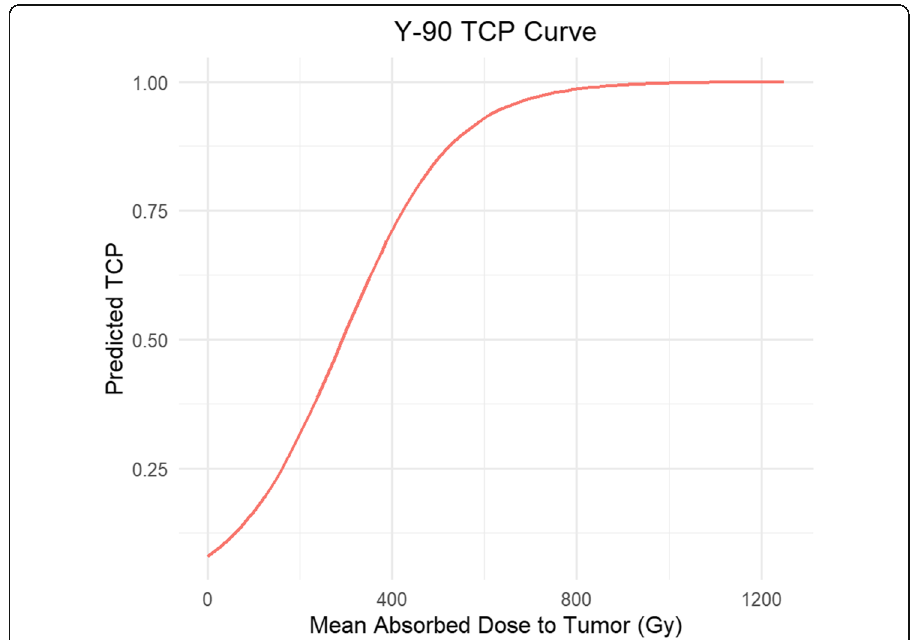
Fig. 2 Fitted tumor control probability model for mean tumor dose from prior study